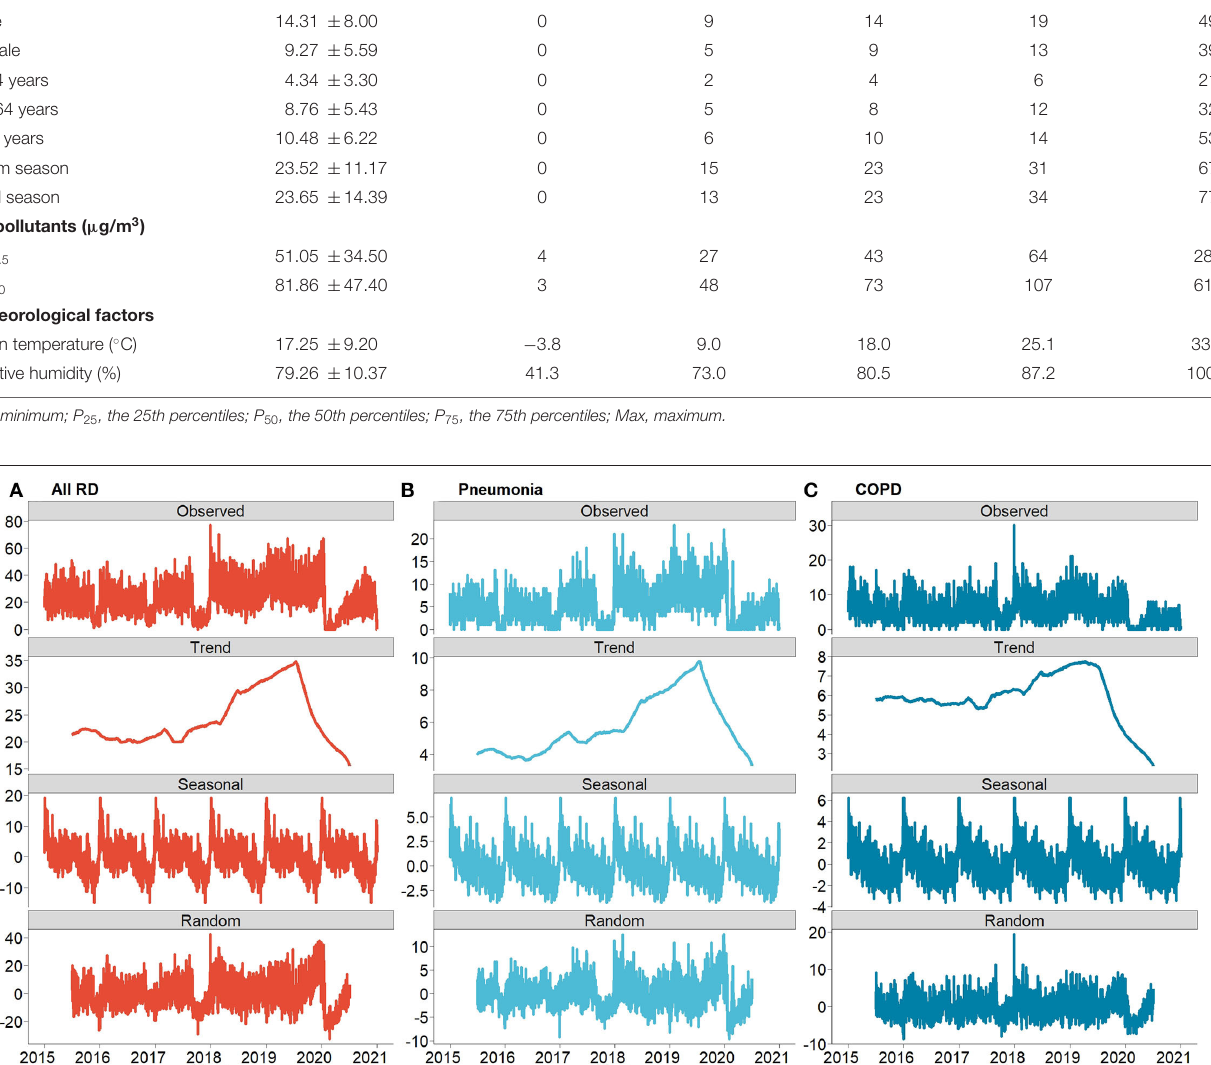
of 65 + years old had the highest hospitalization cost in all age groups. The average LOS of patients with RD showed a decreasing trend from 10.14 days in 2015 to 8.41 days in 2019 and increased to 9.92 days in 2020. The LOS of patients with COPD was relatively consistent with the trend of all RDs, whereas the LOS of patients with pneumonia increased markedly in 2020 and exceeded all RDs and COPD.